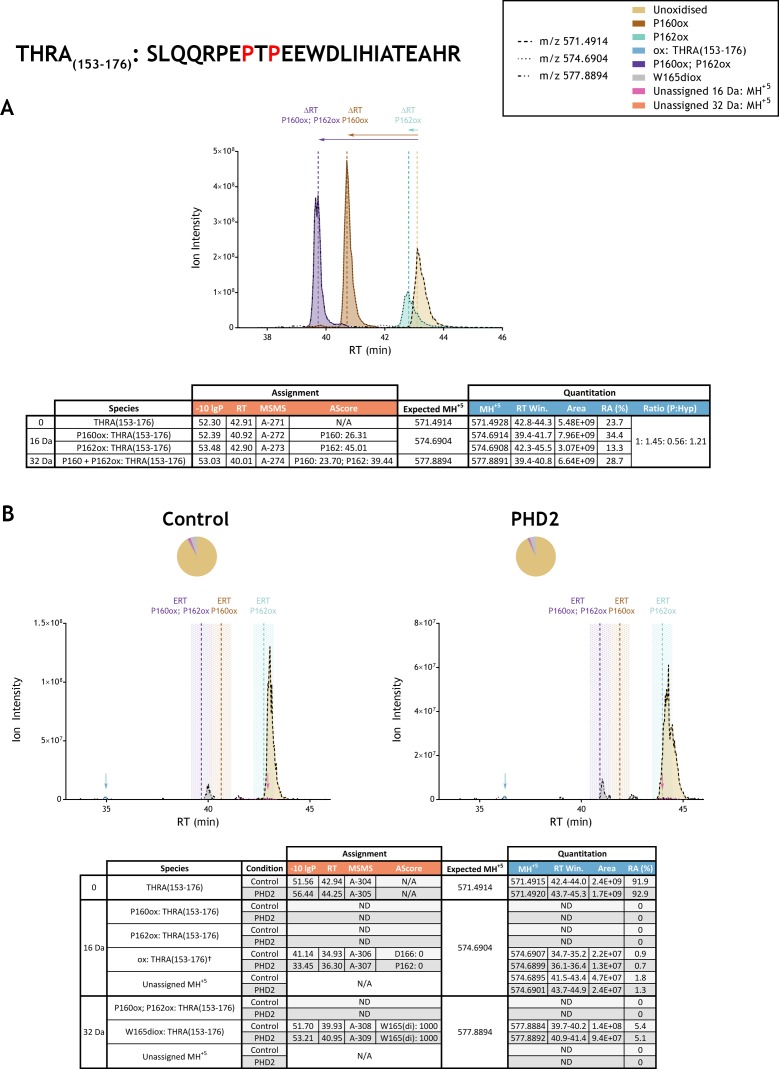
Quantitation of peptide oxidation on THRA(153-176) following reaction of full-length thyroid hormone receptor alpha with recombinant PHD2.XIC data presented in (A) shows ion intensity and retention time (RT) characteristics of equimolar synthetic peptide standards for unoxidised and proline oxidised forms (P160ox, P162ox or combined) of the THRA(153-176) peptide. MSMS assigned species are coloured (see inset); vertical dashed lines define peak maxima used to derive ΔRT values for the different hydroxyproline-containing peptides. Panel (B) shows comparable XIC data for protease-digested IVTT substrate under control (left) or PHD2-reacted (right) conditions. Peaks corresponding to unoxidised (light brown) and low stoichiometry singly-oxidised (blue arrow) and doubly-oxidised (grey) forms of THRA(153-176) were detected in control and PHD2-reacted IVTT preparations. The site of oxidation was ambiguous in the context of the singly-oxidised peptide (nominally localised to P162 or D166: AScore 0; see Supplementary file 1 A-306 and A-307 respectively for MSMS) and assigned as tryptophan di-oxidation (W439: AScore 1000; see Supplementary file 1 A-308 and A-309 for MSMS) on the doubly-oxidised peptide. The elution profile of the low abundance singly oxidised ions was chromatographically distinct (>5 min) from the expected retention time (ERT) of hydroxyproline-containing peptides (indicated by dashed vertical lines; shading corresponds to a 1 min RT window) and did not change in abundance relative to the unoxidised peptide following reaction with PHD2. Peptide ions of low abundance that were compatible with a single (+16 Da) oxidation event but not assigned by MSMS are indicated (pink arrow); unassigned ions with a compatible mass over charge for double oxidation (i.e.,+32 Da) were not observed across the elution window. Quantitative data for observed species are presented as pie charts with XIC data. Assignment and quantitation data are tabulated below each panel, table headers are as follows: (−10lgP) significance score of leading assignment at given (RT) with ambiguity score (AScore) for PTM localisation and reference to primary MSMS data in Supplementary file 1. Species column: Fragment ions (including neutral loss ions) localise mono-oxidation† to residues 165–166 (see Supplementary file 1, A-306). Quantitative data reports ion counts (Area) of observed masses (MH+5) integrated over time (RT Win.), expressed as relative abundance (RA). Data on detection efficiency for synthetic peptides (Panel A, P: Hyp) is an aggregated ratio of prolyl (P) to hydroxyprolyl (Hyp) containing species.